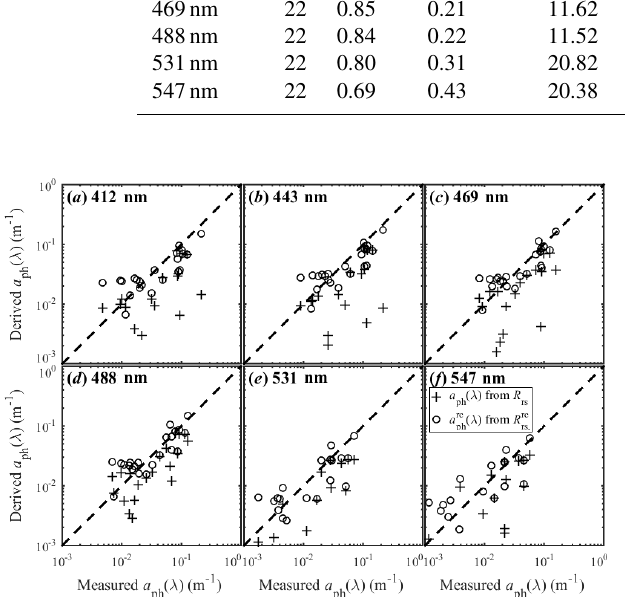
Figure 6. Comparison of the satellite-derived a ph (crosses) and satellite-derived a rc (open circles) with in situ measured data at ph 412, 443, 469, 488, 531, and